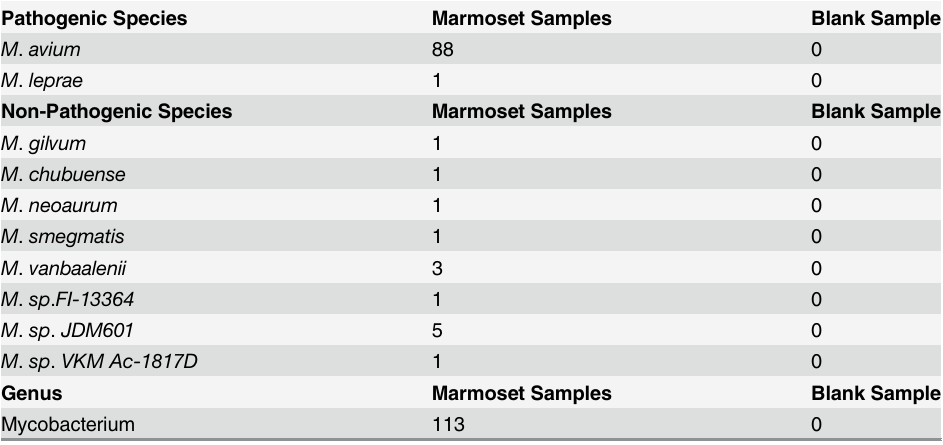
Table 3. Summary of MEGAN